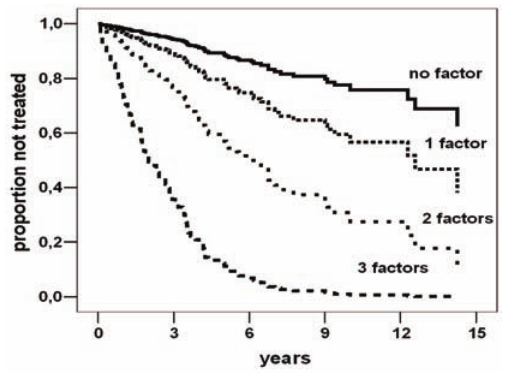
Figure 1. Results. An abnormal sFLC k / λ was found in 134 of 403 untreated CLL cases (116 k , 18 λ ). A significant correla- tion was observed for sFLC k / λ , CD38 and ZAP-70 as well as for IGHV status. CLL cases were divided into three groups according to sFLC k / λ abnormality. The 3.0 year probability of TFS for cases with abnormal sFLC k / λ was significantly lower than cases with a normal sFLC k / λ (64% vs 63% vs 83%, p <0.0001). Since abnor- mal k and λ sFLC curves overlapped, combining cases with abnormal sFLC k / λ (i.e. k plus λ ) revealed these group had a significantly shorter TFS ( p <0.0001, median TFS 12.3 years) as compared to patients with normal sFLC k / λ (median TFS 4.1 years). Univariate Cox ana- lysis showed 76 of 380 CD38+ cases (H.R. 2.8, 95% C.I. 1.9-4.1, p <0.0001), 134 of 303 ZAP-70+ cases (H.R. 4.5, ted cases (H.R. 4.1, 95% C.I. 2.8-6.0, p <0.0001), and 103 of 361 Binet stage B and C cases (H.R. 2.4, 95% C.I. 1.7-3.4, p <0.0001) had a higher risk of starting